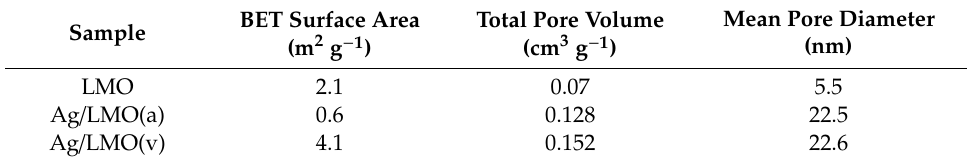
Table 4. BET results and pore structure parameters for pristine LMO and Ag / LMO composites.